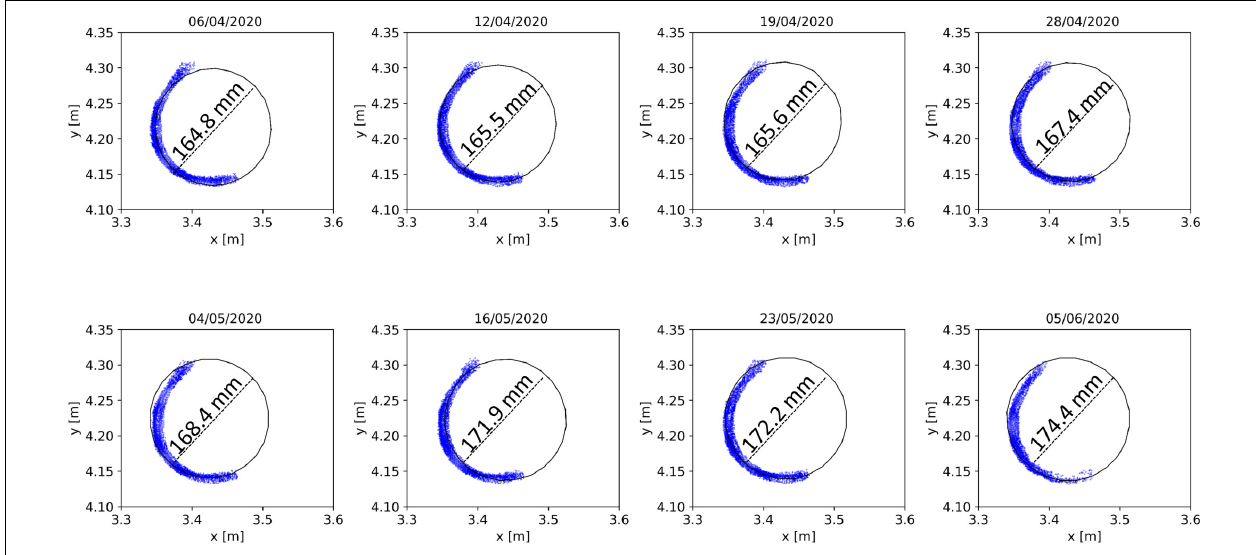
FIGURE 8 | Detection of DBH growth trend from the Silver birch tree point clouds acquired between April 06 and June